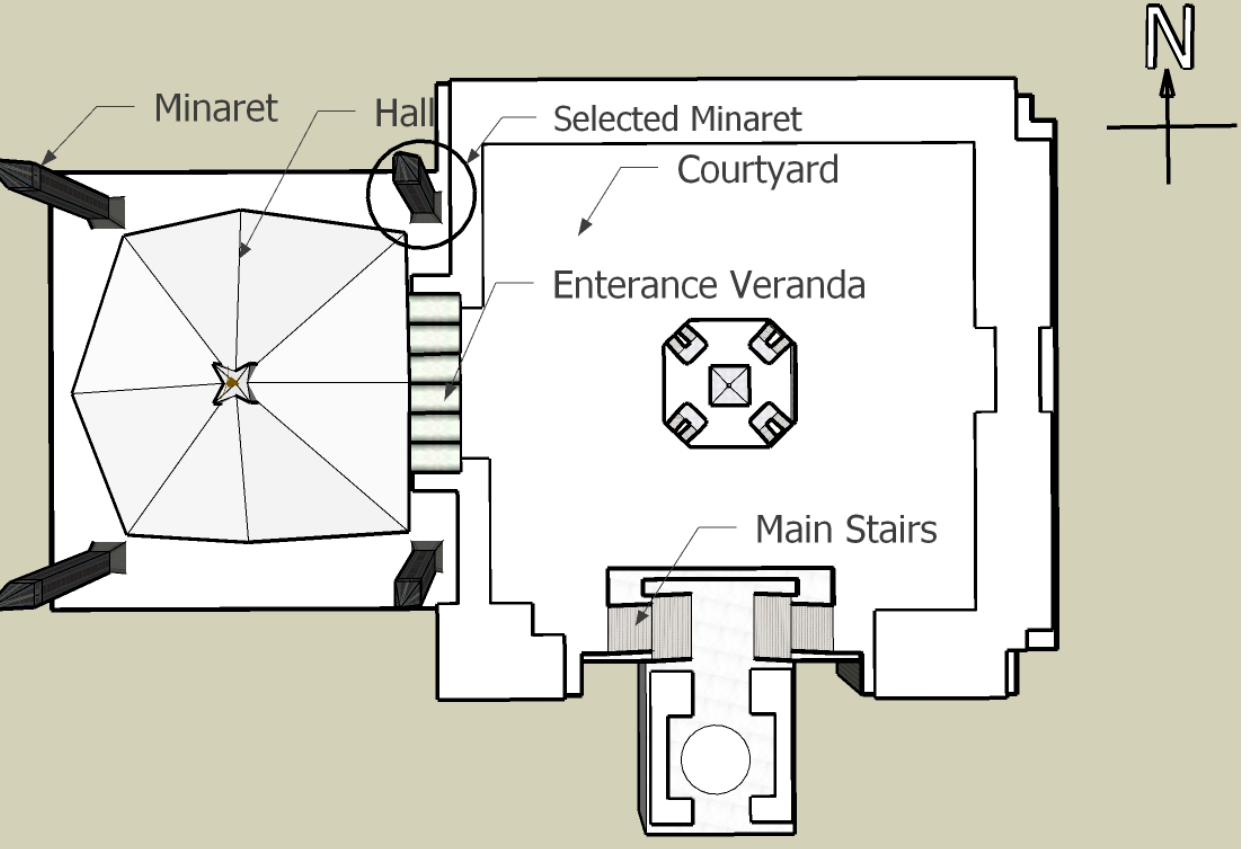
Figure 1. The top view of Faisal Mosque with the encircled minaret considered for this study.